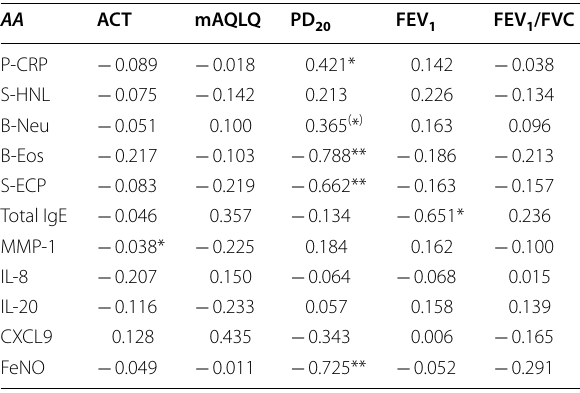
Table 6 Correlations (rho) between clinical outcomes and inflammatory biomarkers in